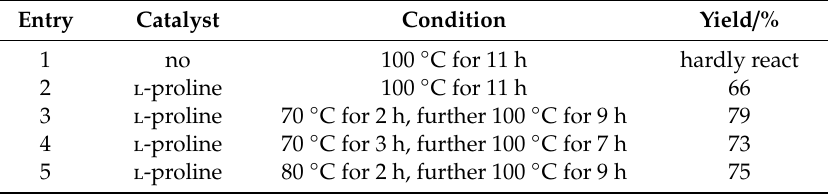
Table 1. E ff ects of reaction conditions on the synthesis of the intermediate 3